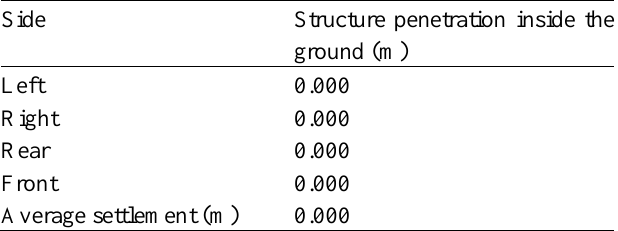
Penetration of Structure inside the Ground in Treated 1-g Physical Model-III with Treatment beneath the Structure